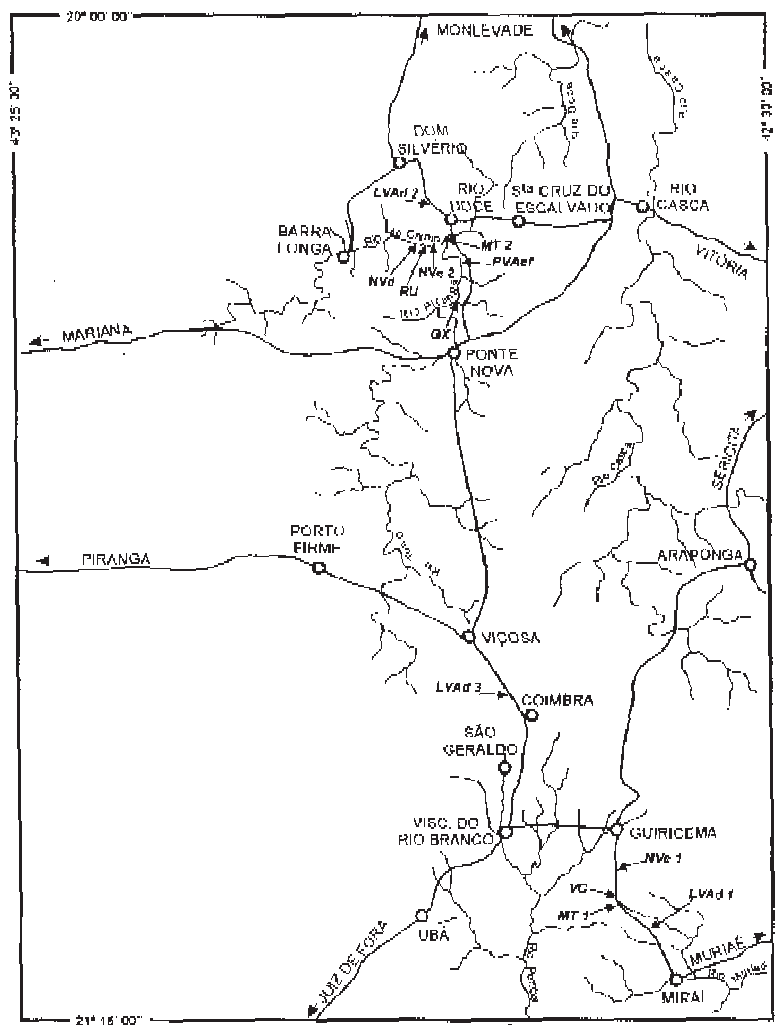
Figura 1. Localização aproximada dos perfis